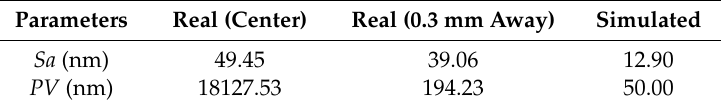
Table 4. The surface roughness and peak-to-valley height of di ff erent areas.